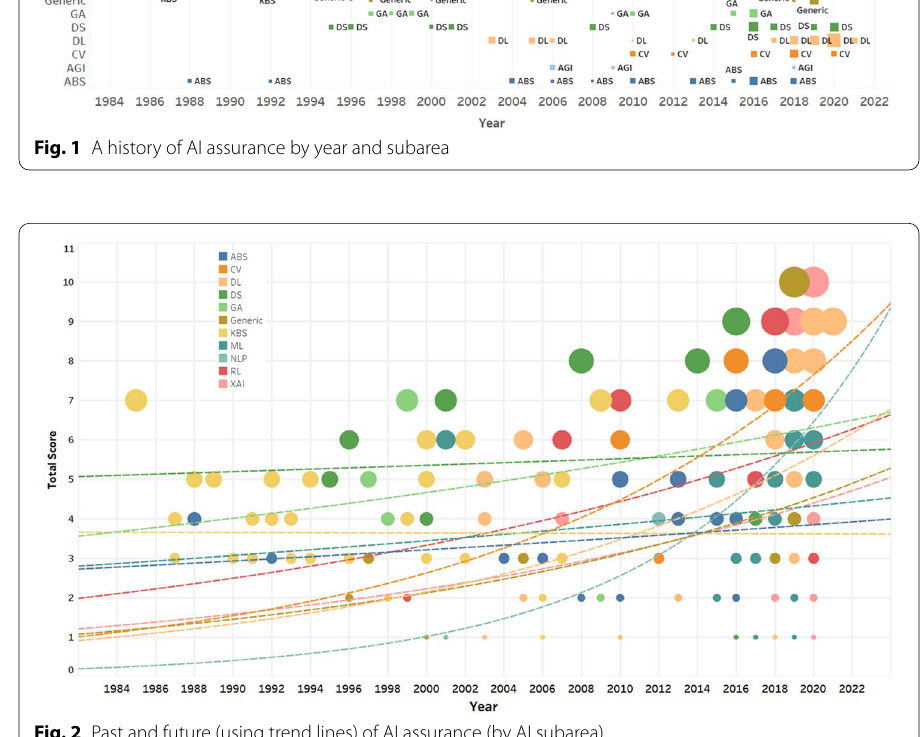
Fig. 2 Past and future (using trend lines) of AI assurance (by AI